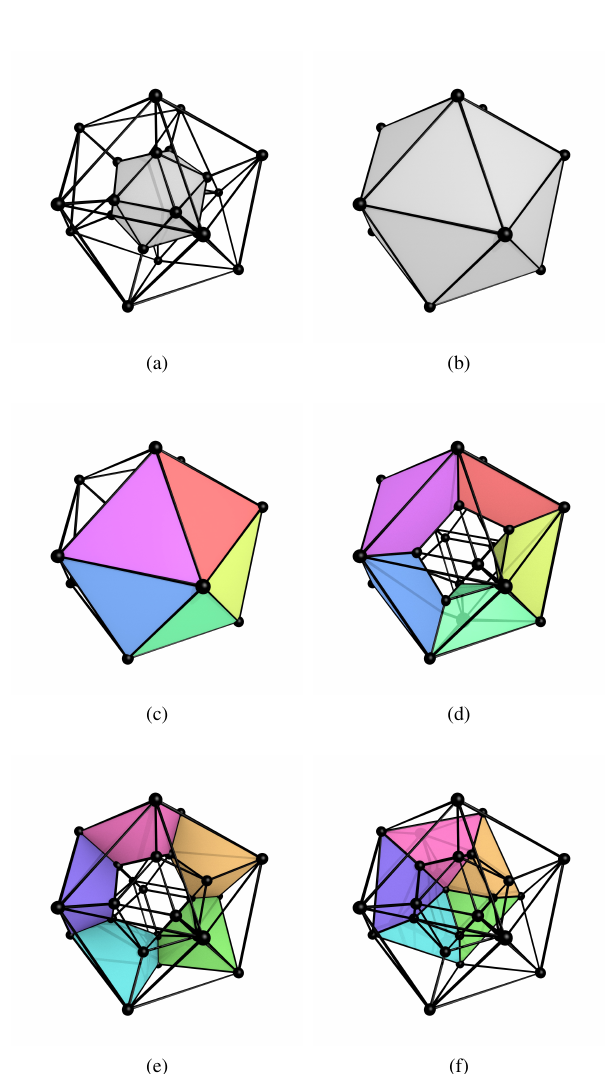
Figure 2: The 24 vertices, 72 edges, 70 faces and 22 volumes bounding an icosahedral prism in a stereographic projection from 4D to 3D, shown here in parts for clarity. Due to the projection used, the fourth dimension corresponds to an inwards-outwards axis. In this manner, the ‘top’ and ‘bottom’ facets (i.e. volumes in this 4D case) of the prismatic polytope are visualised as (a) the inner and (b) the outer icosahedra. Meanwhile, (c–f) the other facets are triangular prisms that join corresponding ridges (i.e. faces in this 4D case) of the top and bottom